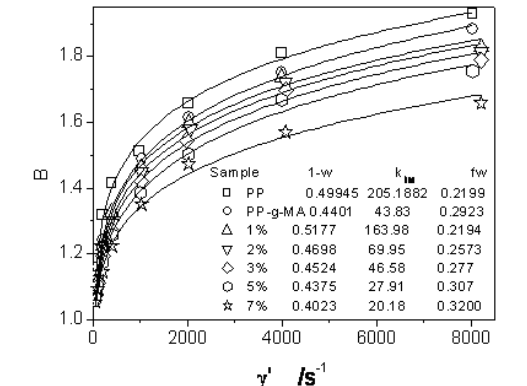
Figure 1. The die swell ratio of iPP/organobentonite nanoparticles of different filler